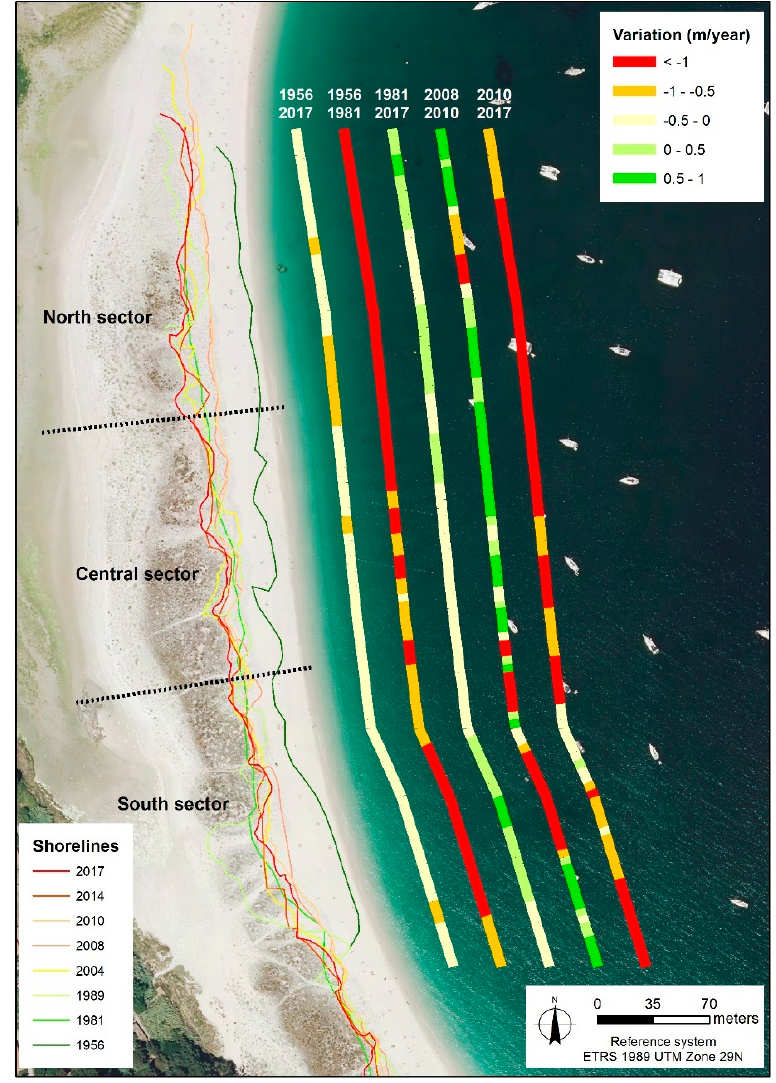
Figure 6. Shoreline variation for all periods. The thin lines in the sand represent the shoreline position on each date. The change is represented parallel to the coastline in the sea and the variation is represented in m/year by the end point rate (EPR) for 1956–1981 and 2008–2010 and by LRR for the